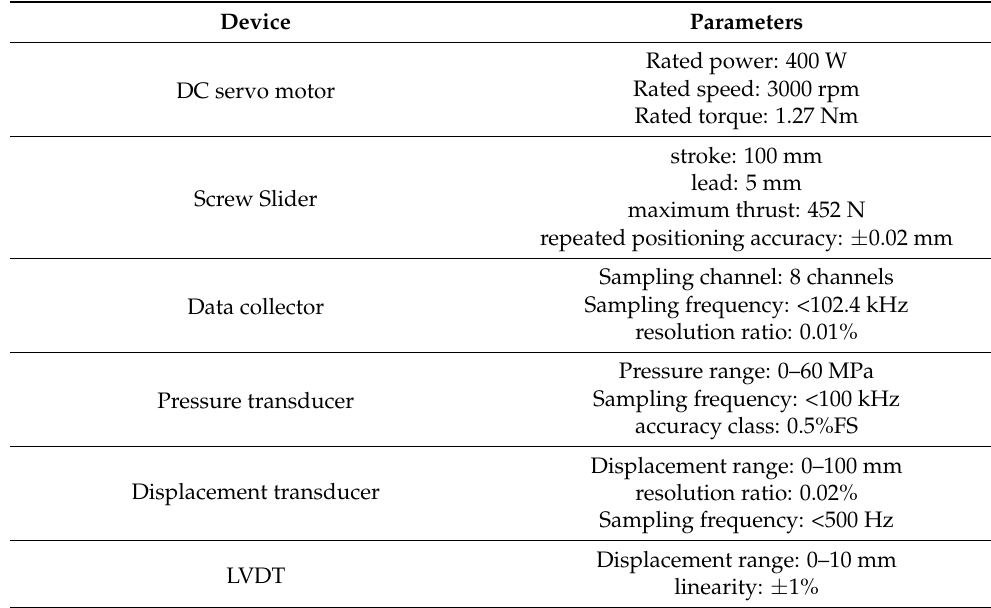
Table 1. The test device parameters.